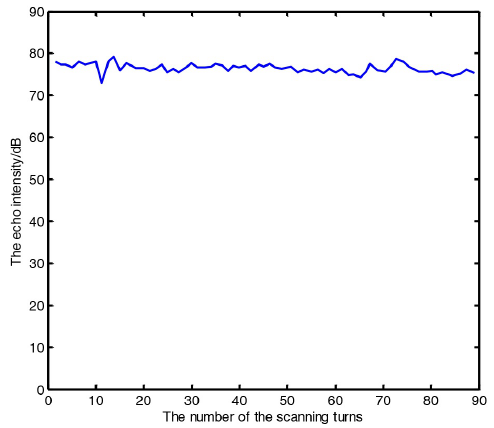
Fig. 4 The echo signal of the small Luneburg lens reflector.